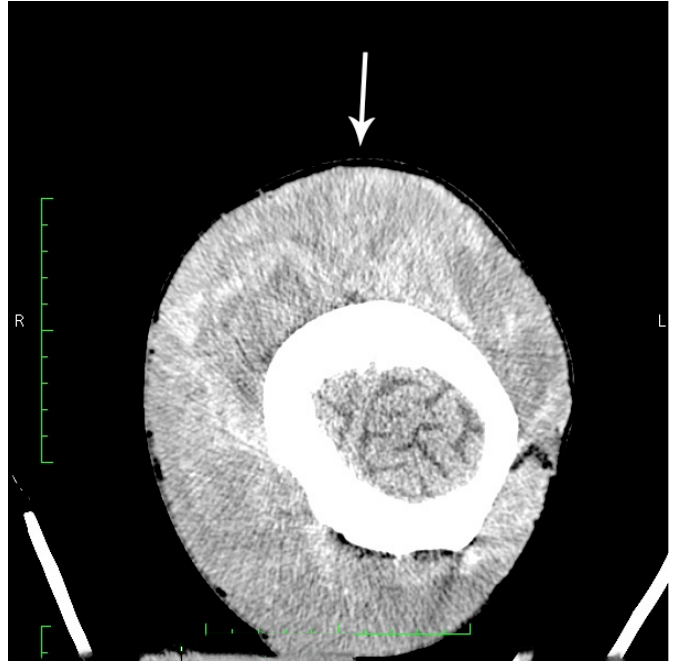
Figure 2. Computed tomography demonstrating extensive cephalohematoma in the soft tissues of the